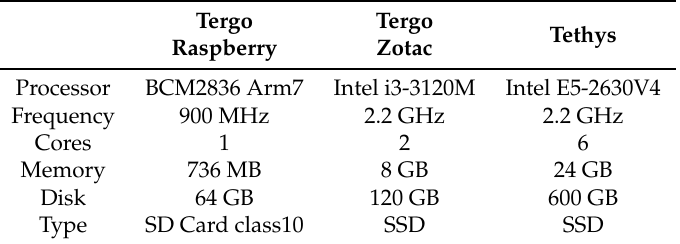
Table 3. Technical specifications of edge